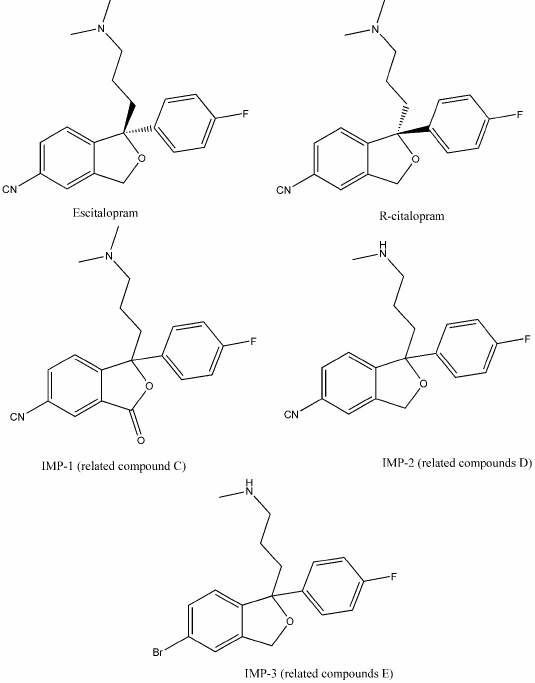
Figure 1. Chemical structure and abbreviations of the compounds used in this study.